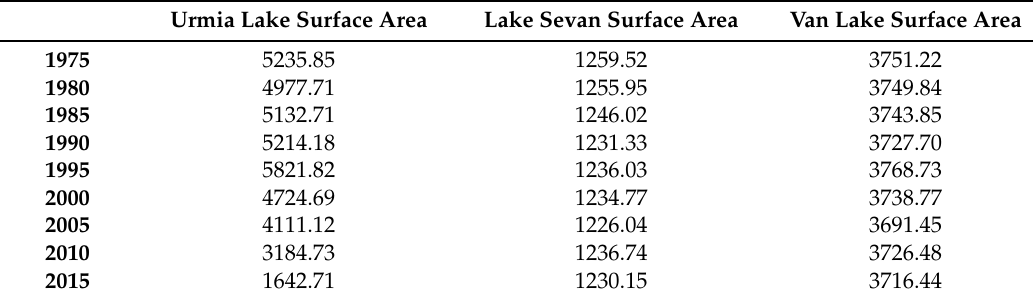
Table 3. The lakes surface area changes (km 2 ) generated by MLP NNs